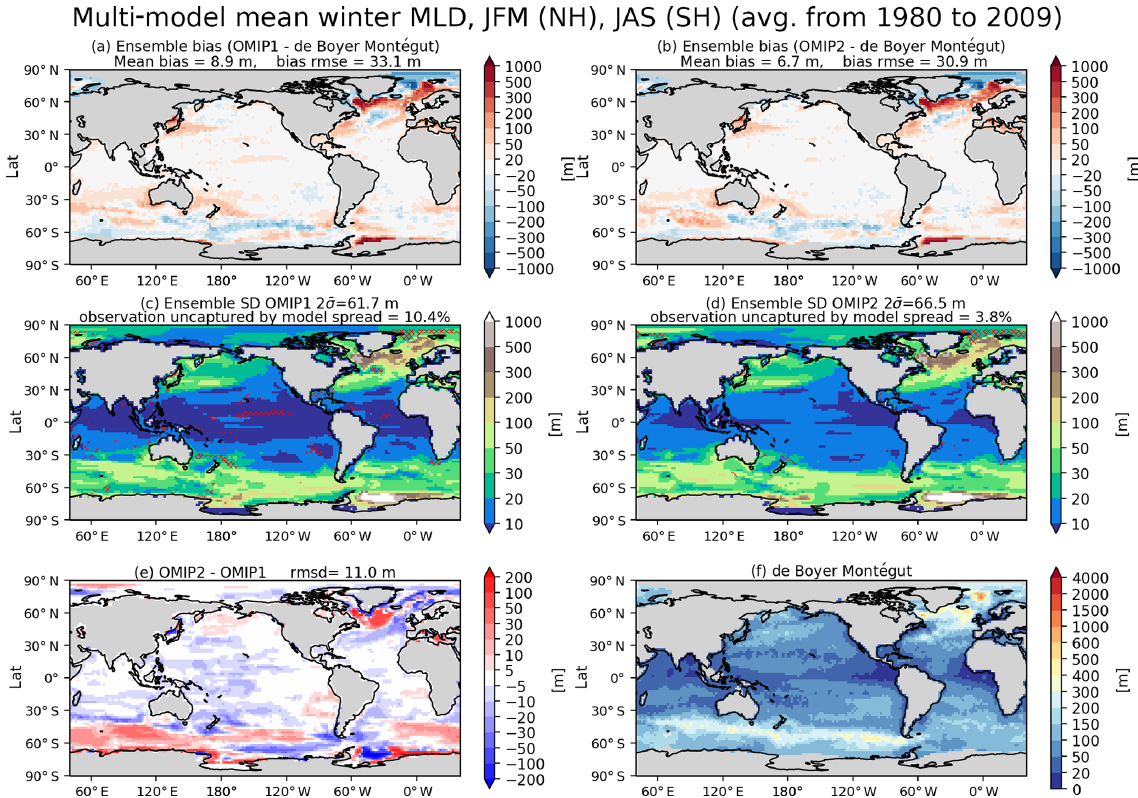
Figure 11. Evaluation of simulated mixed layer depth (m). Panels (a) and (b) show the bias of the multi-model mean, 30-year (1980–2009) mean winter mixed layer depth in both hemispheres relative to observationally derived mixed layer depth data from de Boyer Montégut et al. (2004). January–February–March mean for the Northern Hemisphere and July–August–September mean for the Southern Hemisphere. (a) OMIP-1 and (b) OMIP-2. The middle two panels show the standard deviation of the ensemble, with the regions where the observation is outside the 95% confidence range of the model spread ( ± 2 σ ) hatched with red. (c) OMIP-1 and (d) OMIP-2. (e) Difference between OMIP-1 and OMIP-2 (OMIP-2 minus OMIP-1), which is not statistically significant at 95% confidence level everywhere. (f) Observationally derived mixed layer depth data from de Boyer Montégut et al. (2004). At the top of each panel, global mean values are depicted as in Fig. 6. Note that the regions where mixed layer depths could reach more than 1000m in winter, specifically the marginal seas around Antarctica (south of 60 ◦ S) and the high-latitude North Atlantic (50–80 ◦ N; 80 ◦ W–30 ◦ E), are excluded from the computation of global means. See Figs. S27–S29 for results of individual